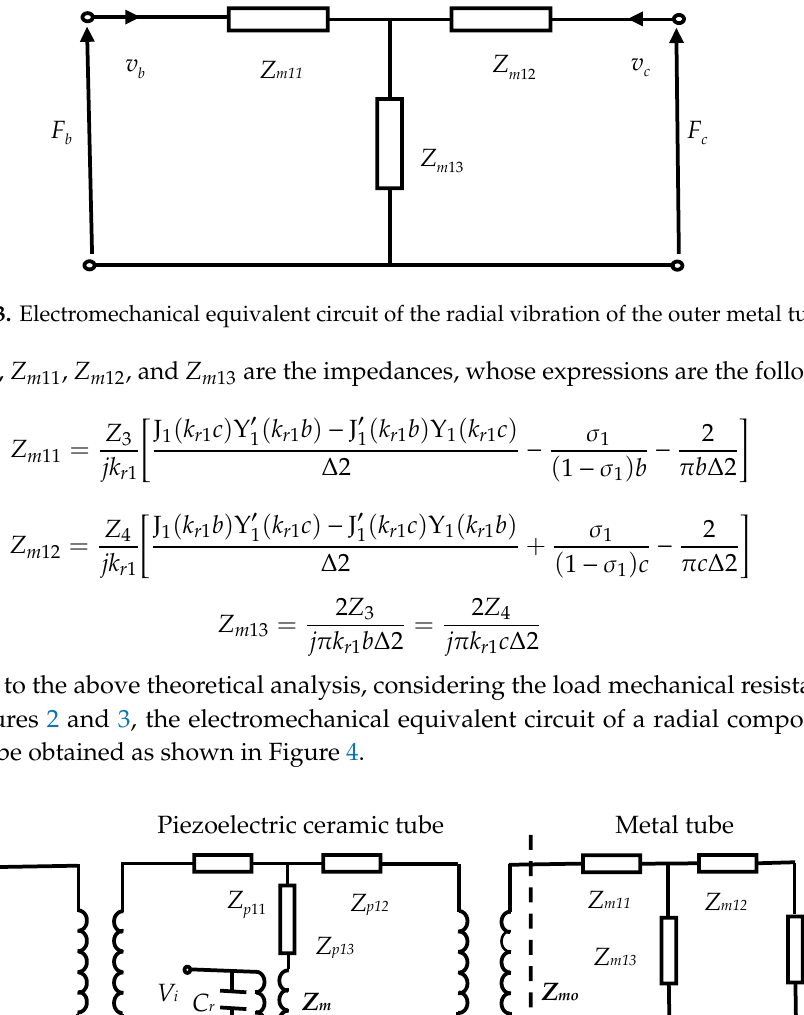
Figure 3. Electromechanical equivalent circuit of the radial vibration of the outer metal tube.